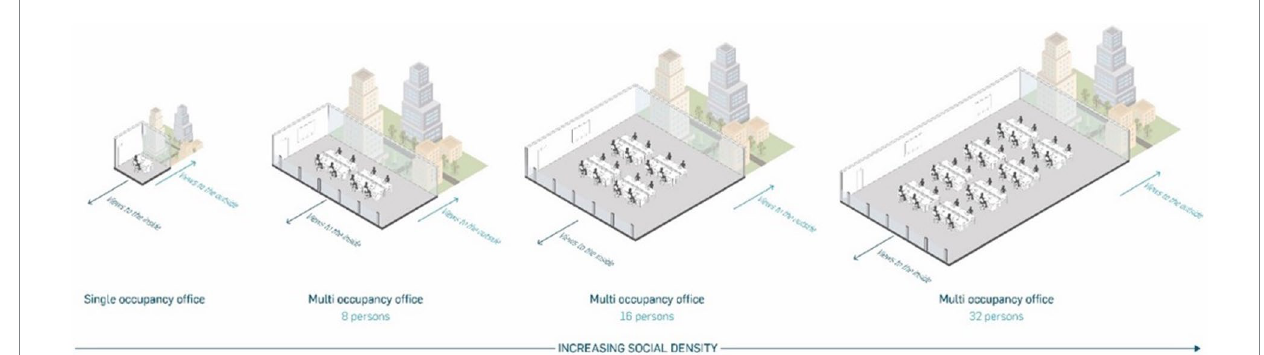
FIGURE 1 A demonstration of increasing social density with a constant spatial density (the personal space around each person remains the same), for a single occupancy, and an 8-, 16-, and 32-person shared office. Reproduced with permission from Jicol et al.